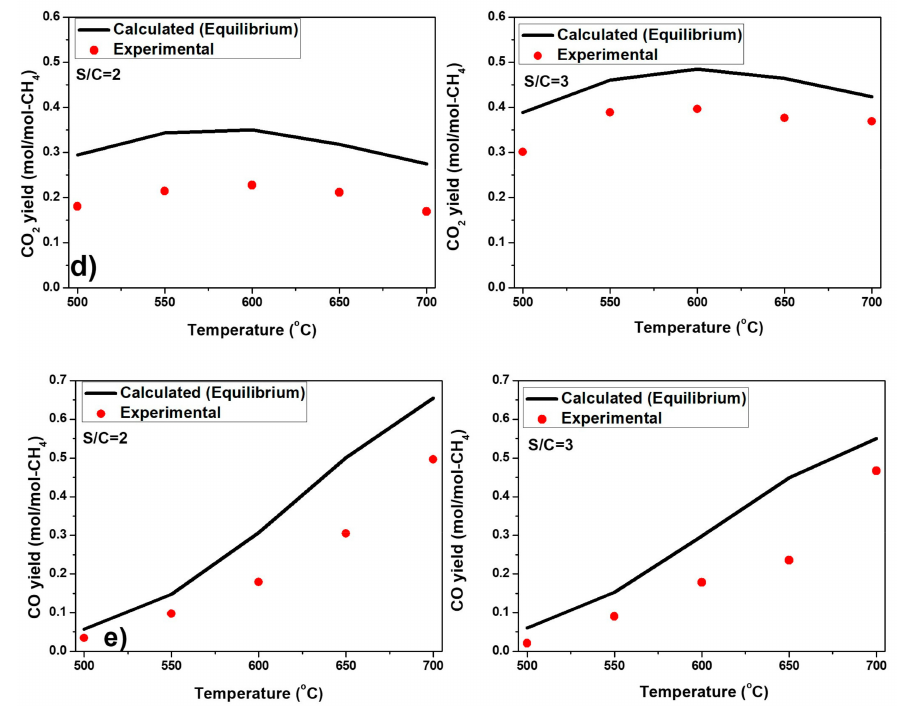
Figure 4. Experimental and calculated methane (equilibrium) steam reforming for 10%Ni/Al 2 O 3 catalyst at various methane reaction temperatures for S/C of 2 and 3: ( a ) methane conversion, ( b ) water conversion, ( c ) hydrogen yield, ( d ) carbon dioxide yield and ( e ) carbon monoxide